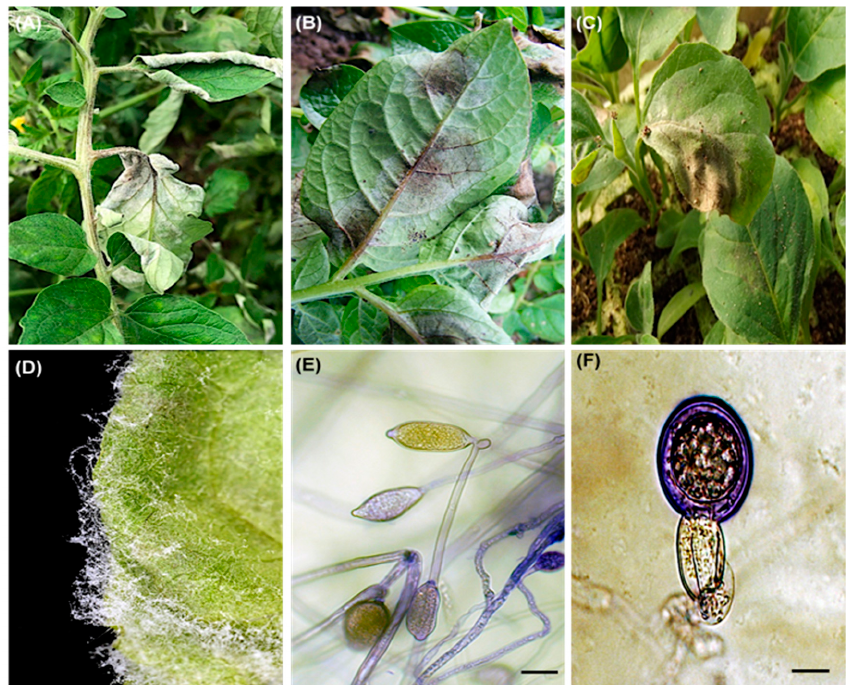
Figure 2. Late blight lesion on tomato plant showing white sporulation on the abaxial side of infected leaves ( A ), sporulated lesions on potato leaves ( B ), late blight symptoms on eggplant leaves ( C ), a close-up image of sporulating lesions and sporangia ( D ), microscopic view of semi-papillate sporangia ( E ), oospore inside an oogonium attached with an amphigynous antheridium ( F ). Scale bar 10 µm.